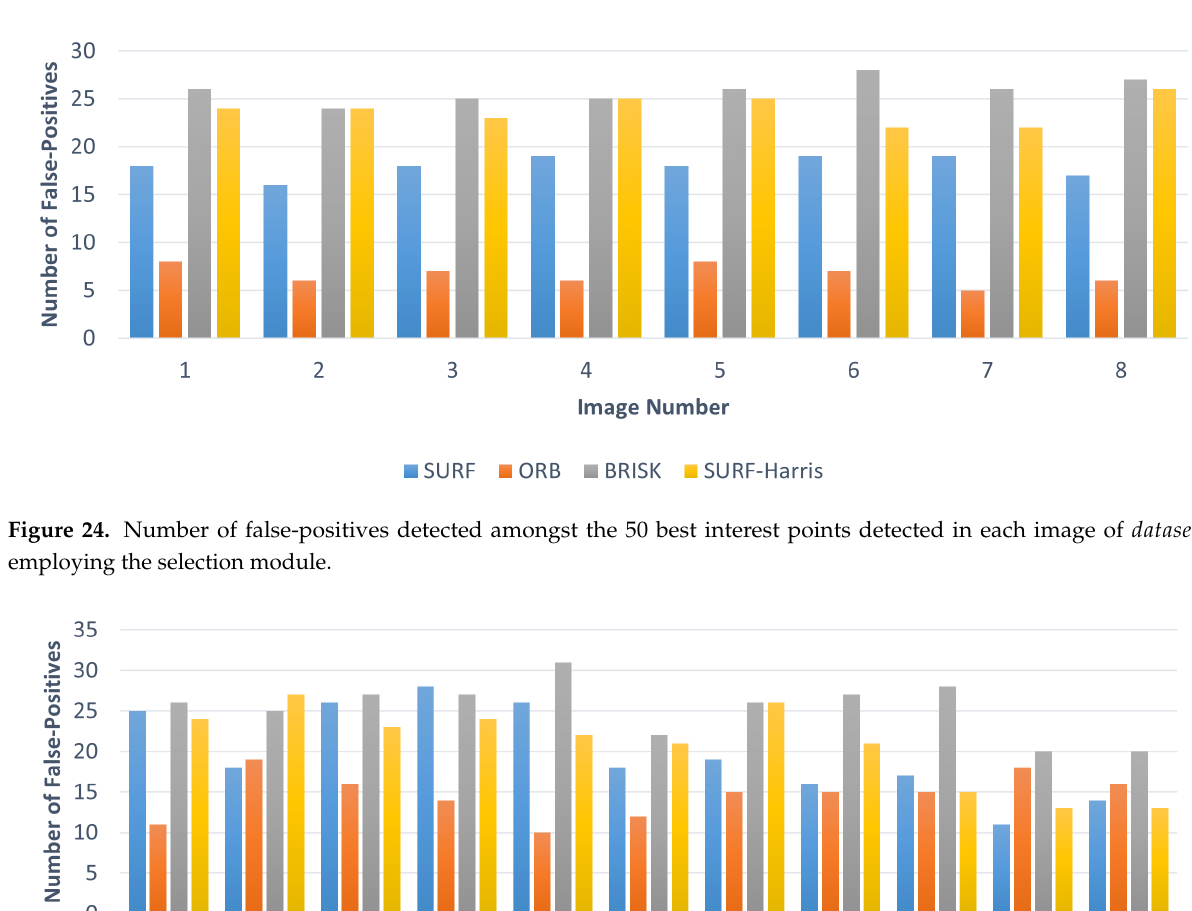
Figure 23. Total number of detected interest points in dataset 2 employing the selection module.